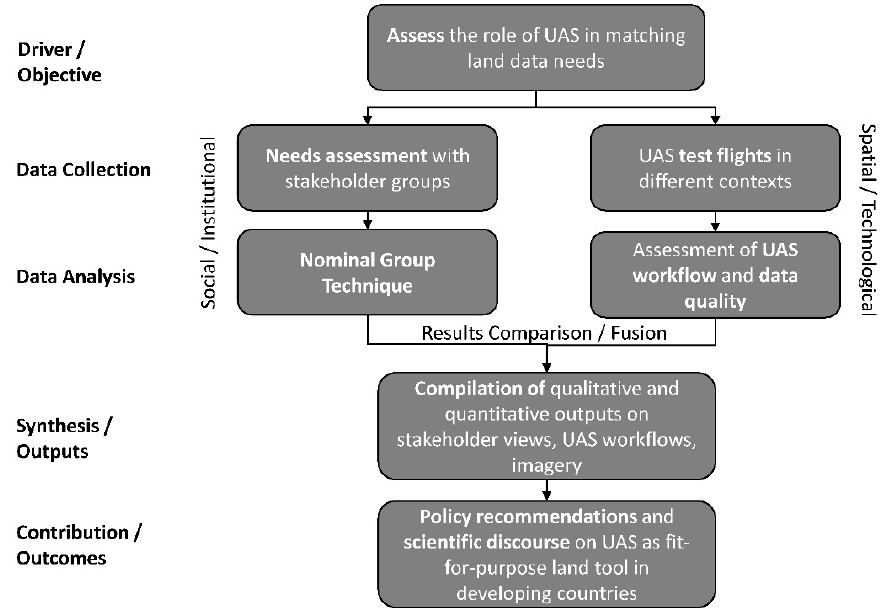
Figure 1. Conceptual framework of the multi-disciplinary approach.